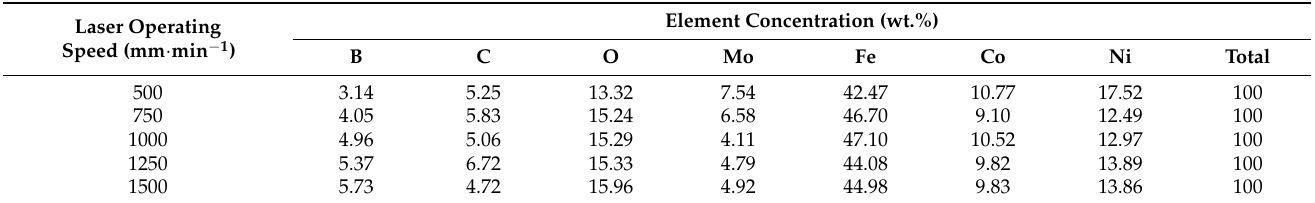
Table 3. Elemental composition of laser-alloyed surfaces (by XPS; after Ar sputtering for 90